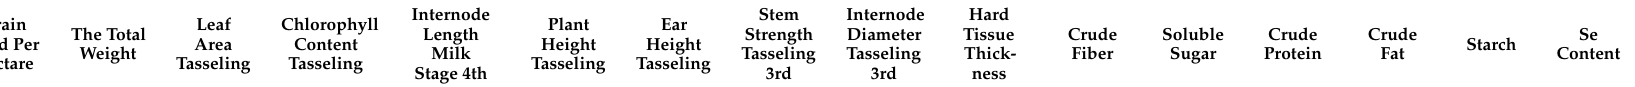
Table 4. Pearson correlation analysis of Se fertilizer and agronomic traits, yield, and quality of dryland maize at location